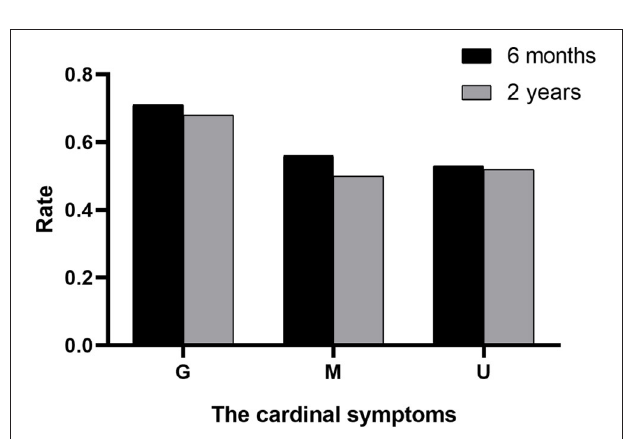
FIGURE 3 | Division of the Krauss index for each improved symptom. G, gait; M, mental; U,